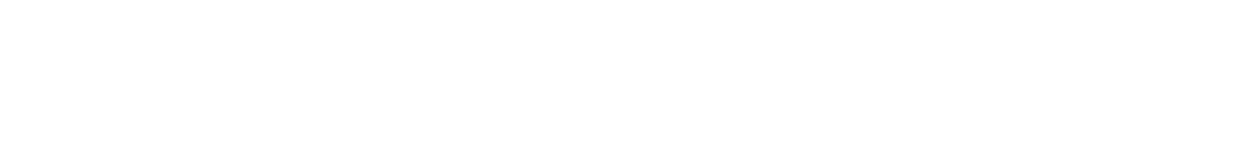
Frontiers in Astronomy and Space Sciences |